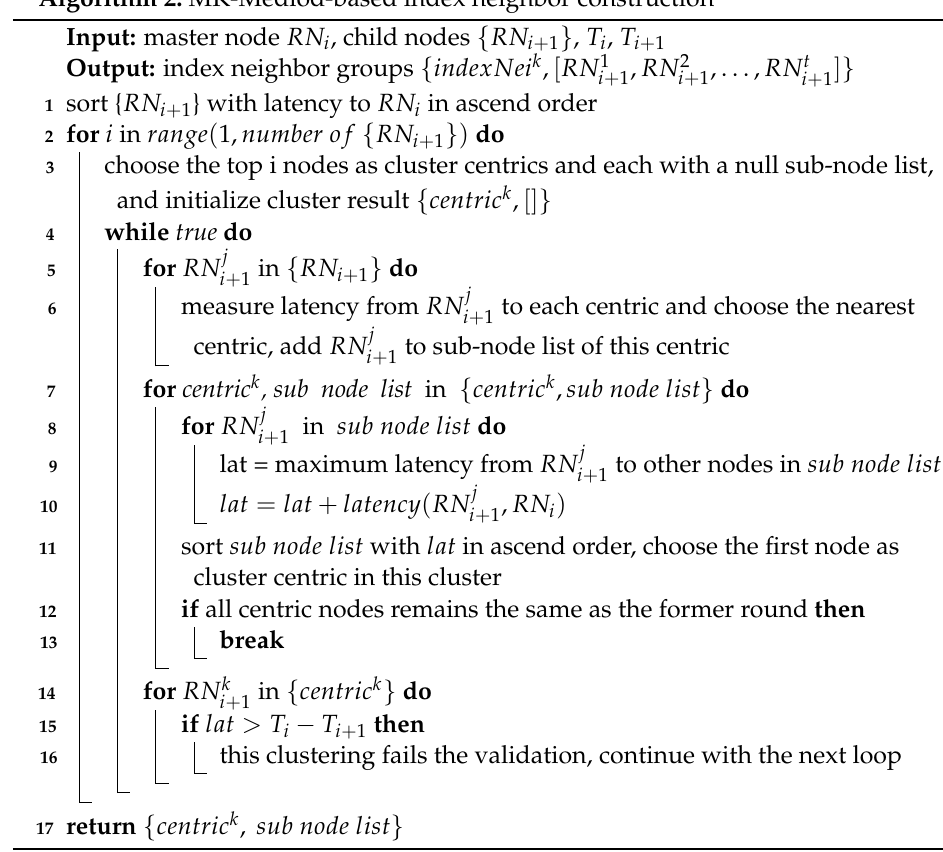
Algorithm 2: MK-Mediod-based index neighbor construction